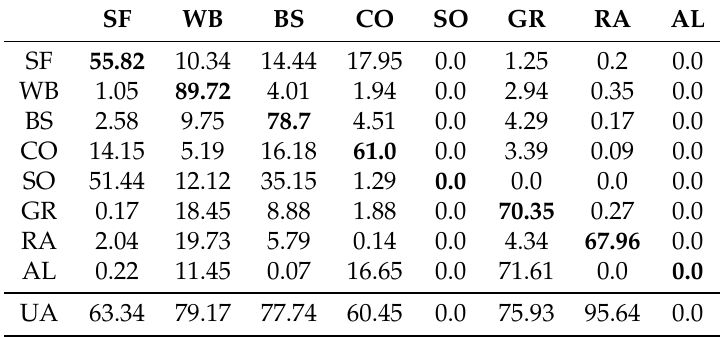
Table 13. Confusion matrix for 23-04-2015 using Landsat8 (9 images). κ = 0.69.